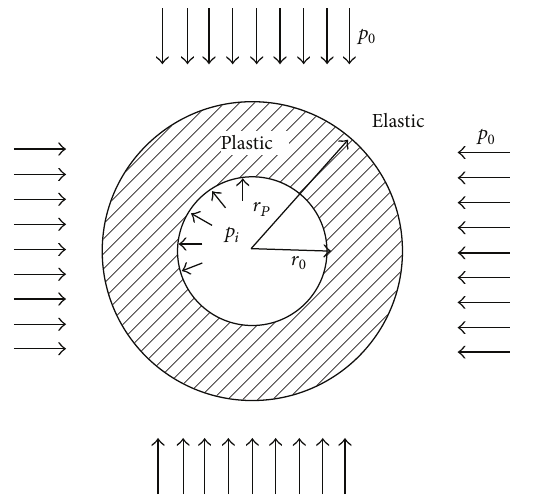
Figure 1: A circular tunnel subjected to hydrostatic far field stress and uniform support